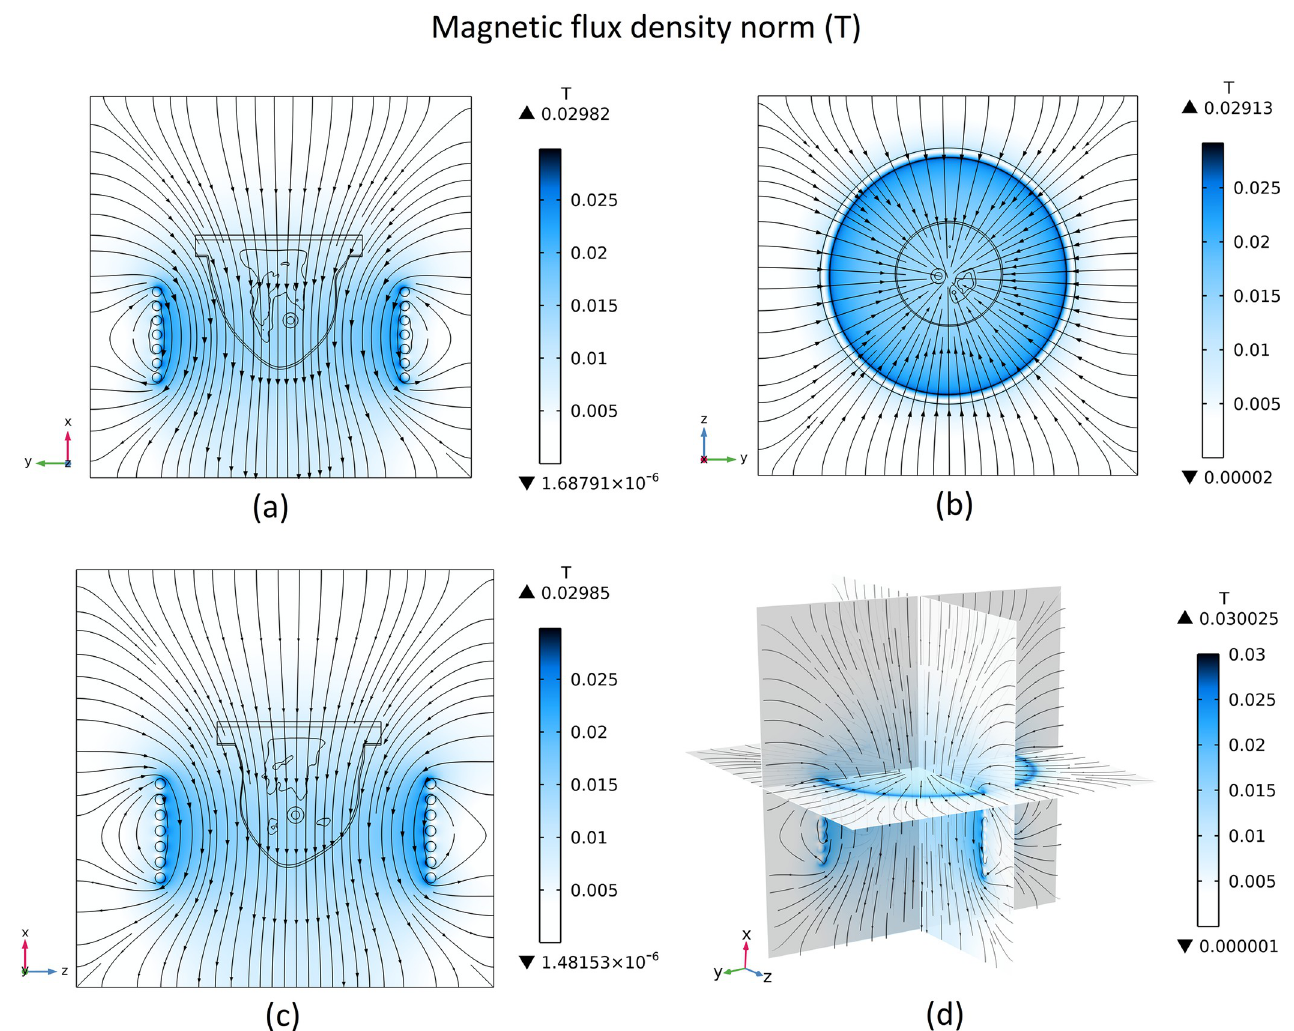
Fig 14. Magnetic flux density norm, (a) x-y surface, (b) z-y surface, (c) x-z surface, (d) 3D view.